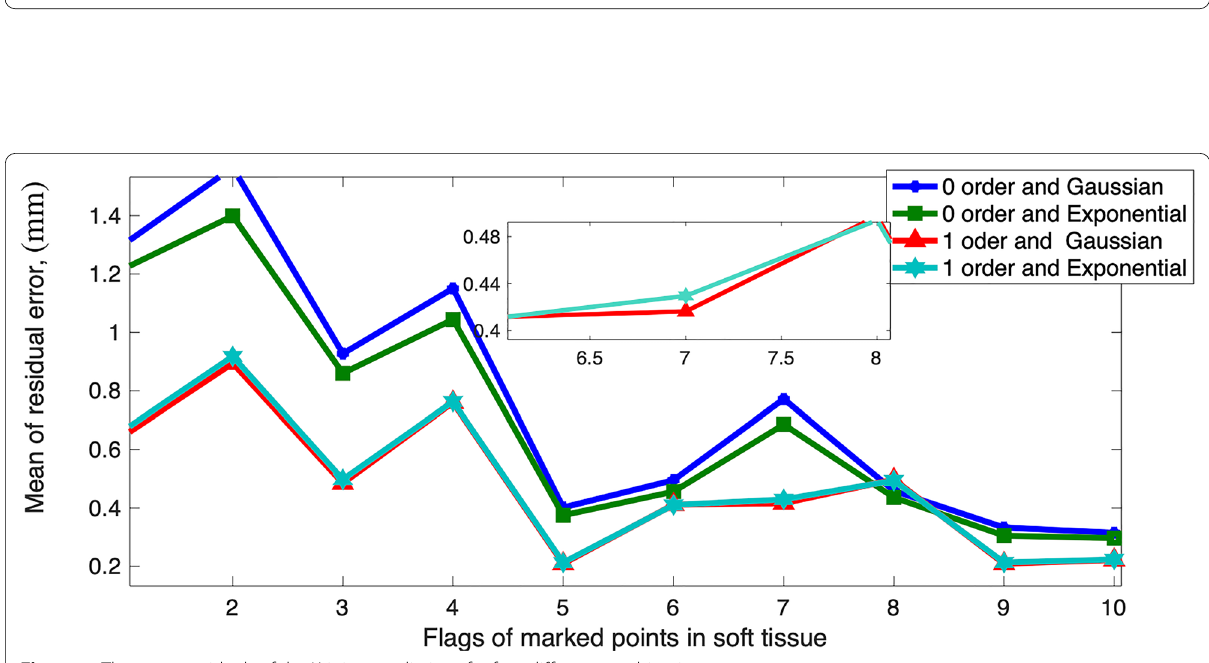
Figure 3 Comparison results of the Kriging and FEM model (The upper-left test, the upper-right test, the lower-left test set and the lower-right test set are X in ( 5, : ) , X in ( 6, : ) , X in ( 7, : ) , X in ( 8, : ) ,respectively )